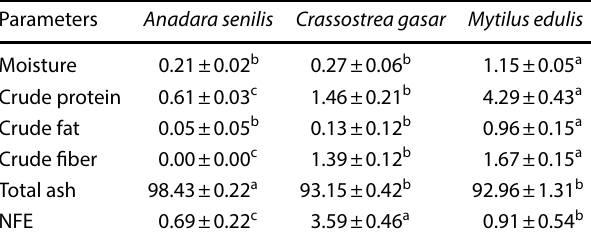
Table 1 Mean concentration of proximate composition of the bivalve shell samples